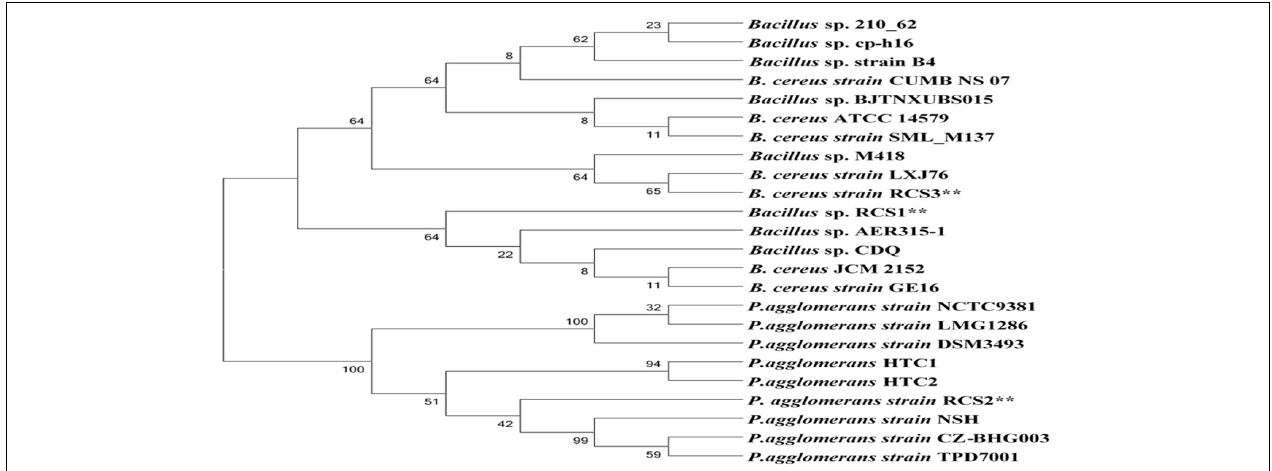
FIGURE 1 | A neighbor joining method was used to construct phylogenetic tree using the sequences of isolated bacterial strains and others from NCBI database in order to identify genetic relatedness.